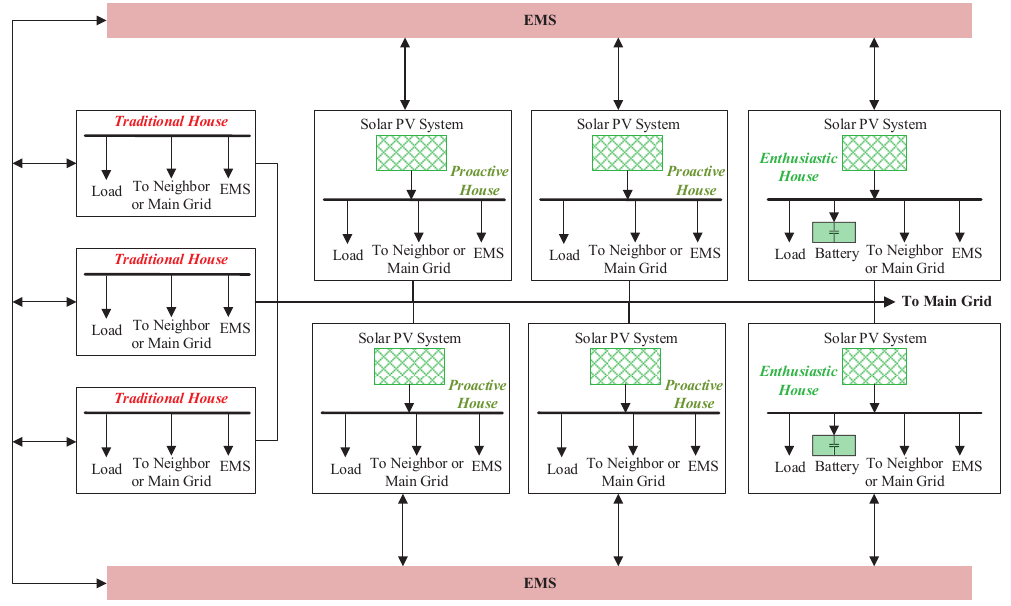
Figure 7. Different houses in a residential microgrid with an EMS.